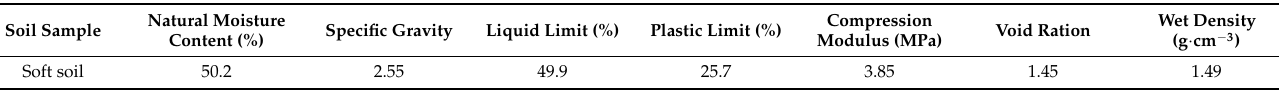
Table 1. Main physical and mechanical property indices of the soft soil.